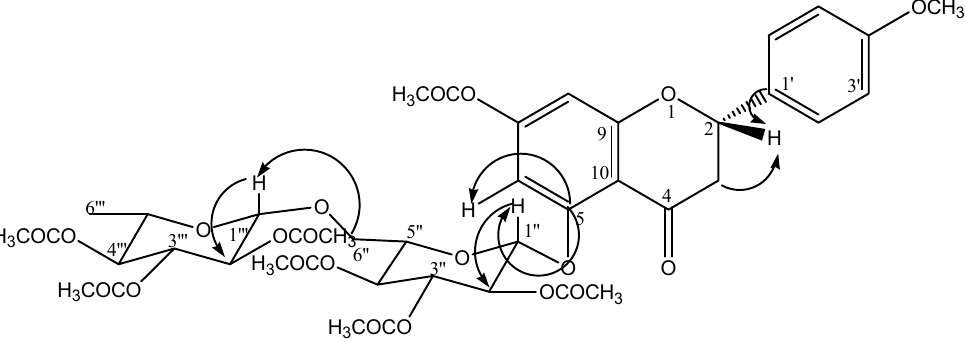
Figure 3. HMBC correlations for C-3, C-5, C-1', H-2, H-1 ″ and H-1 ‴ .